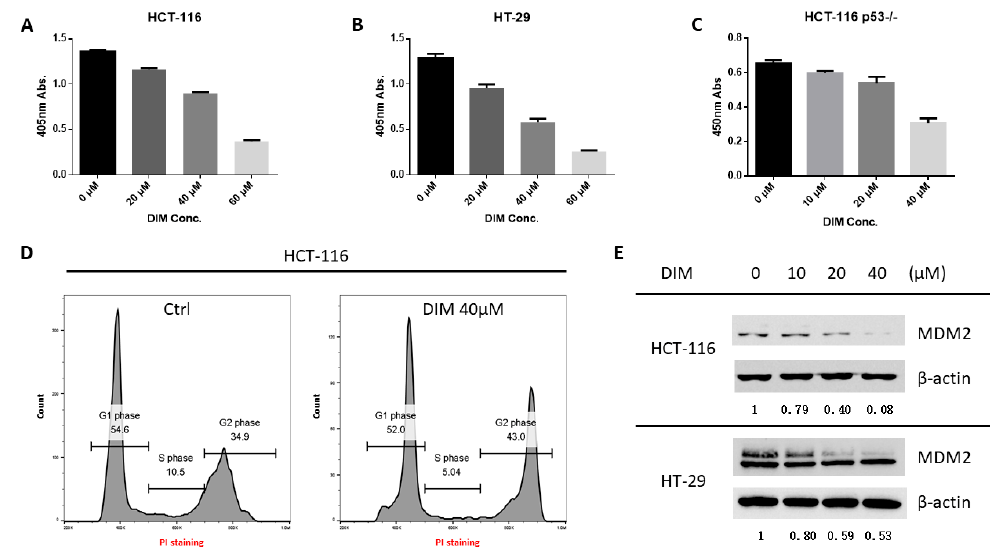
Figure 1. 3,3 (cid:48) -Diindolylmethane (DIM) decreased MDM2 protein in colon cancer cells. ( A ) Figure 1. 3,3 ′ -Diindolylmethane (DIM) decreased MDM2 protein in colon cancer cells. ( A ) HCT-116,